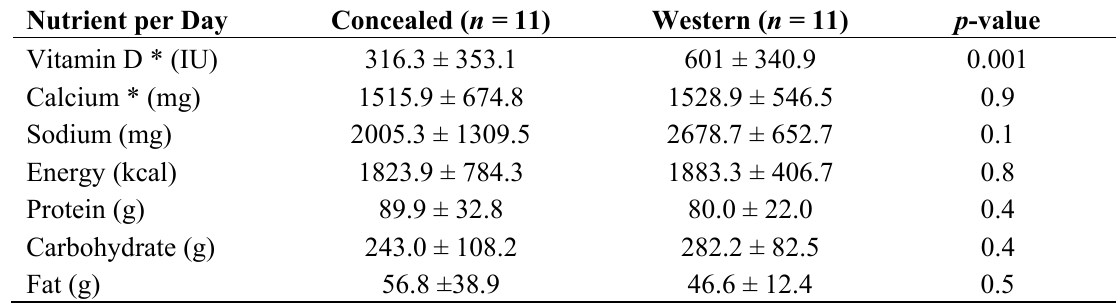
Table 3. Nutrient intake by women who wore concealing versus western-style